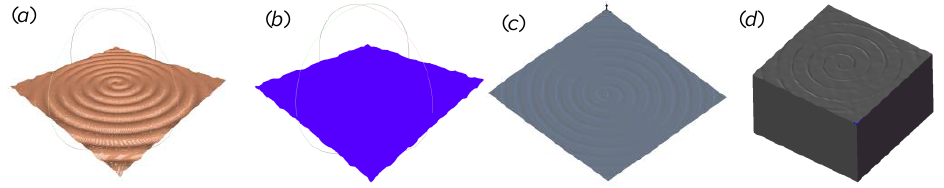
Figure 4. Reverse modeling results. ( a ) Point cloud data; ( b ) Mesh file; ( c ) Feature surface; ( d ) Solid mode.